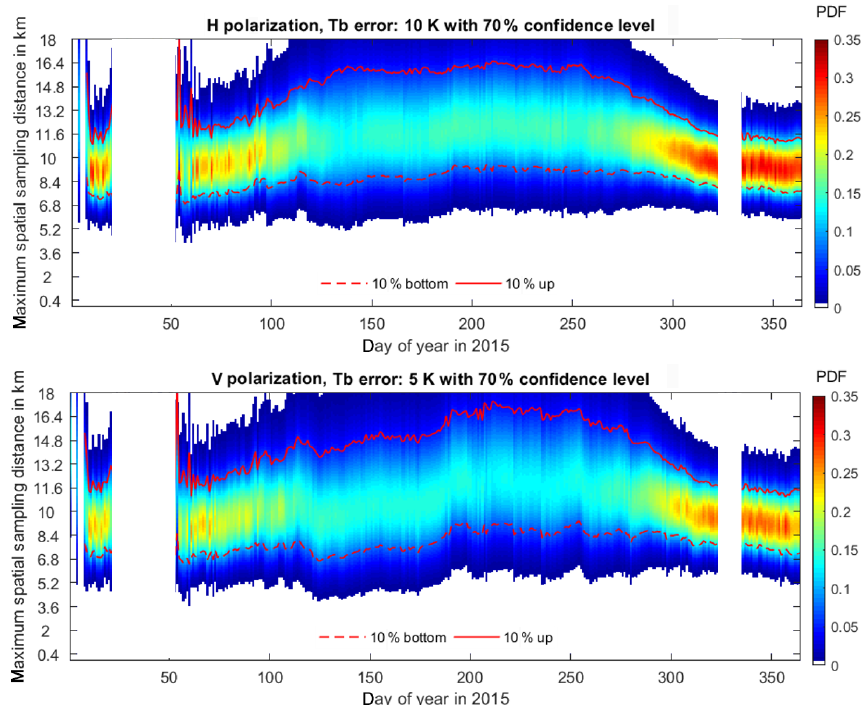
Figure 7. Time series of the distribution of maximum sampling distances (70% confidence in 10K/5K for H/V polarization) for brightness temperature at every sites in 2015. The color indicates the probability of occurrence.